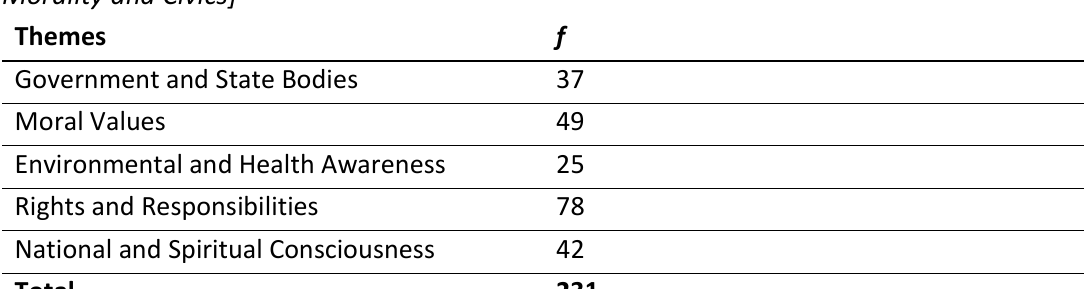
Table 4. Themes and codes in the 1913 Curriculum of Musâhabât-ı Ahlâkiye [Conversations on Morality and Civics]